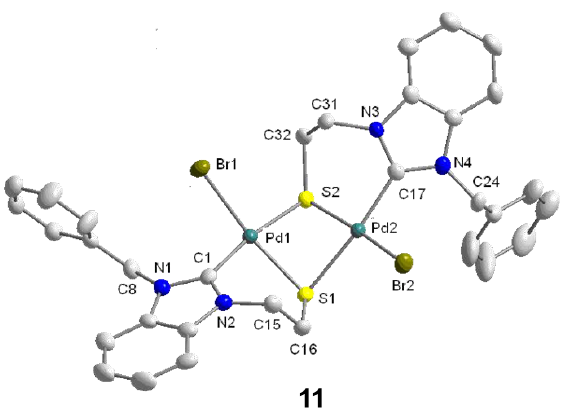
Figure 12. Molecular structure of 11